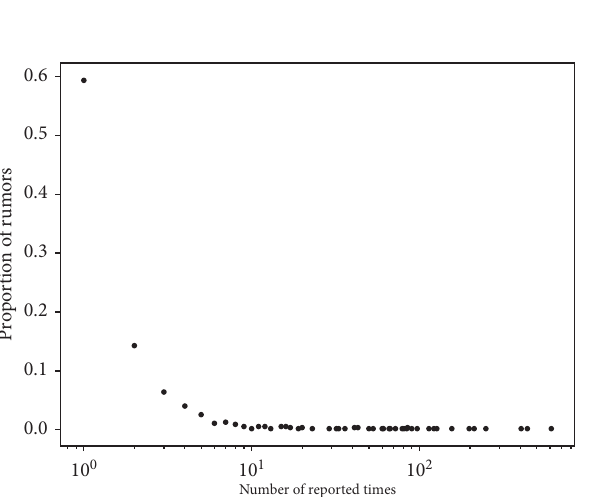
Figure 6: Distribution of reported times of different